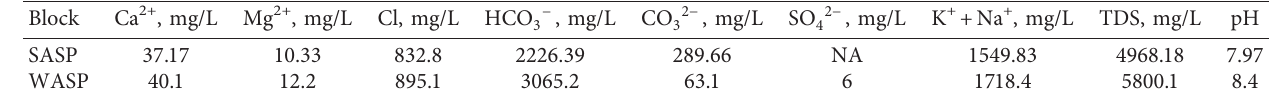
Table 13: Injection water comparison.